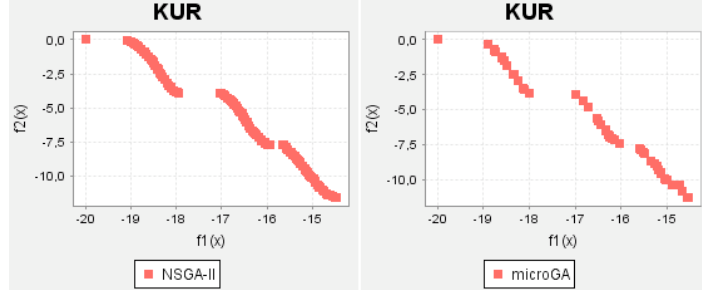
Fig. 5. Results for KUR function